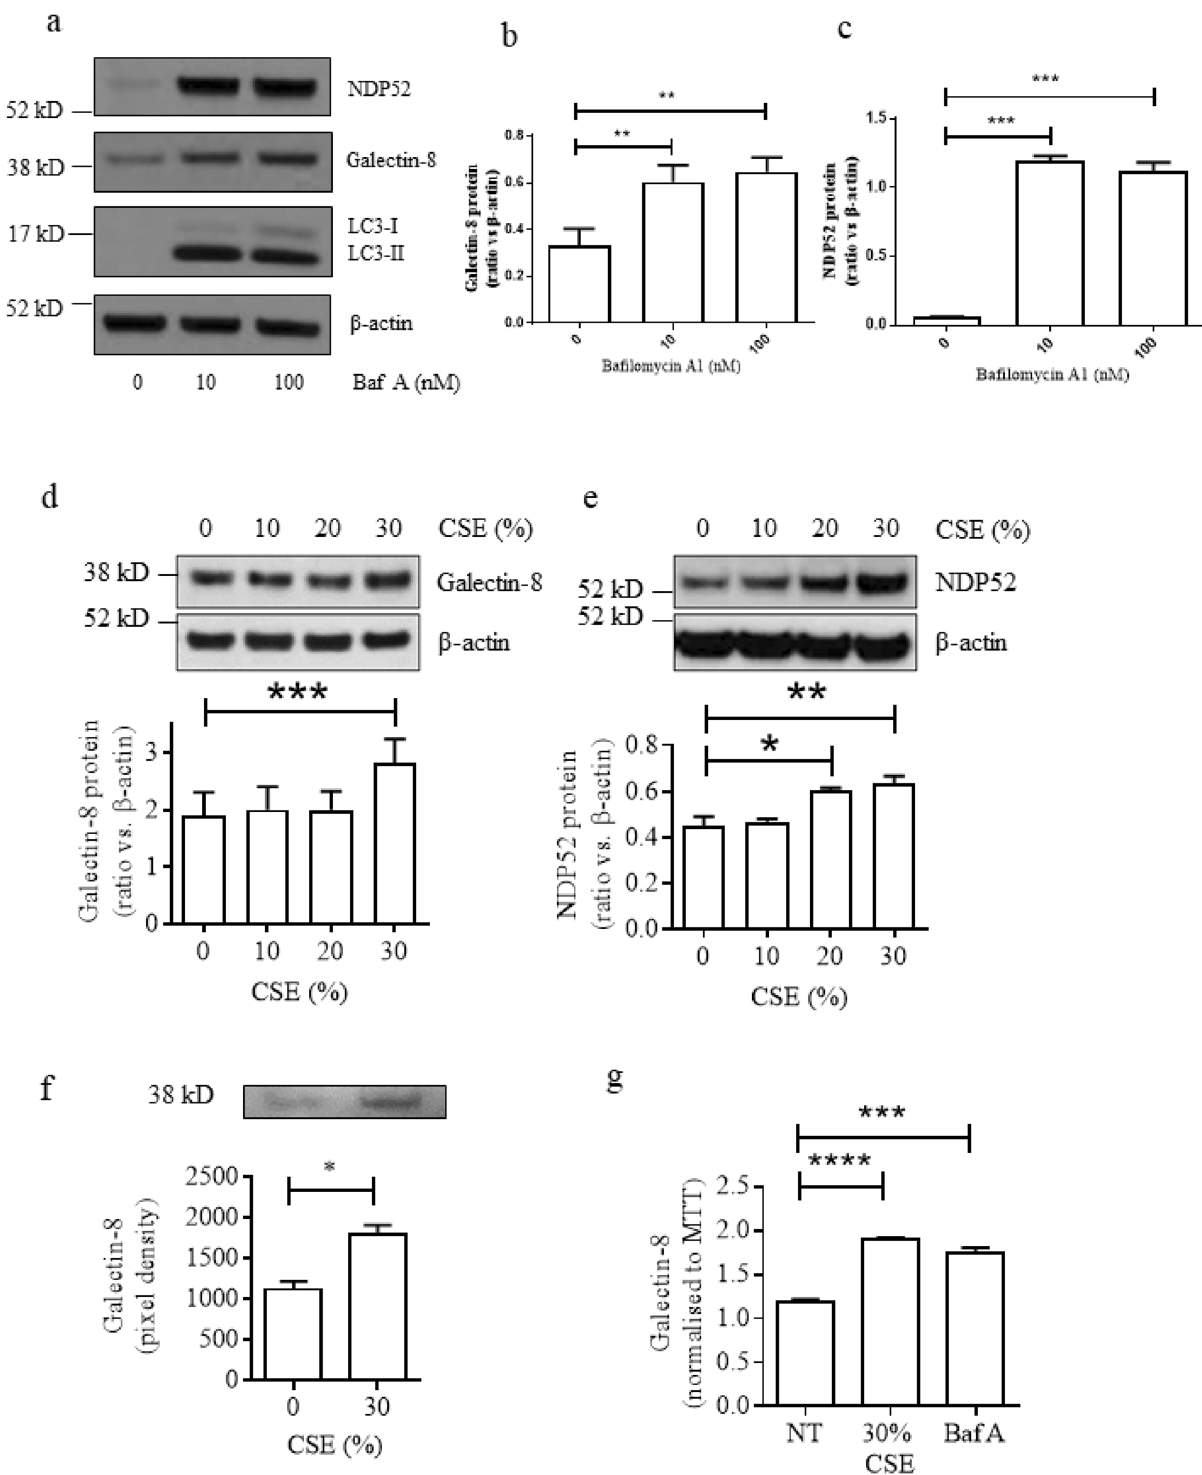
Figure 2. Defective autophagy results in galectin-8 and NDP52 protein accumulation in PMA-differentiated U937 cells. ( a ) NDP52, galectin-8 and LC3 protein expression in cells treated with bafilomycin A; representative images from 3 independent experiments, and the band densities of Galectin-8 ( b ) and NDP52 ( c ) by western blotting analysis, ( d , e ) CSE-induced cellular accumulation of galectin-8 (d) and NDP52 (e); n = 3, ( f ) Western blotting analysis and ( g ) ELISA analysis of secreted galectin-8 protein in supernatant from cells exposed to CSE or Baf A (n = 3). * P < 0.05, ** P < 0.01, *** P < 0.001, **** P < 0.0001. Baf A bafilomycin A, CSE cigarette smoke extract, NT no